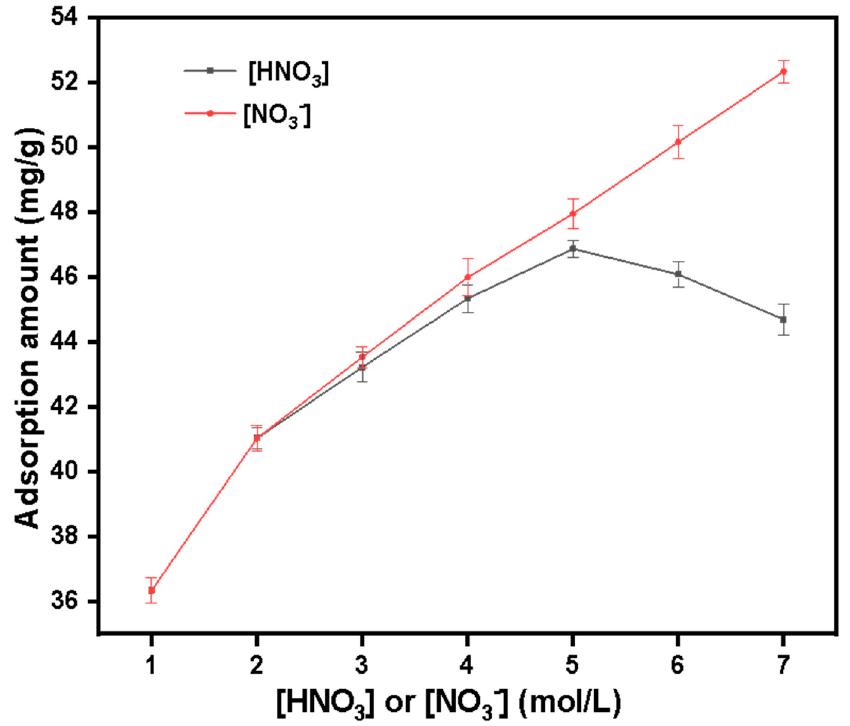
Pu(NO 3 ) 62- has a tendency to form [HPu(NO 3 ) 6 ] − or H 2 Pu(NO 3 ) 6 [43]. Combining the Pu(IV) tends to be an anion exchange form.